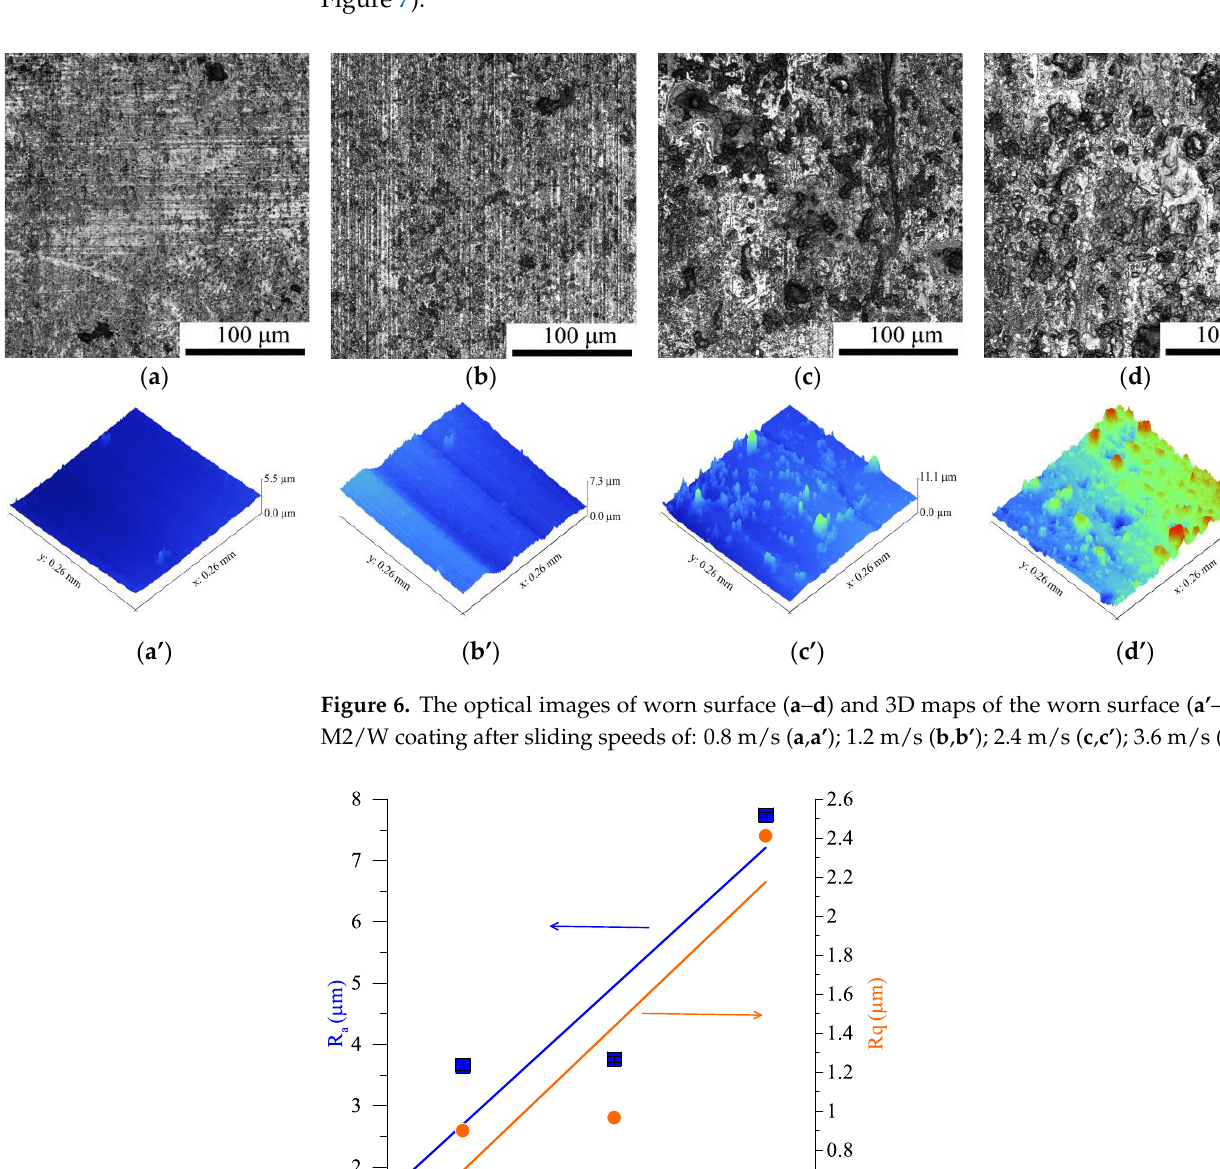
Figure 5. Glancing X-ray diffractograms of initial and worn surface of AISI 52,100 counterbody with incidence angle 5°. Data presented for specimens after sliding speed of 3.6 m/s.